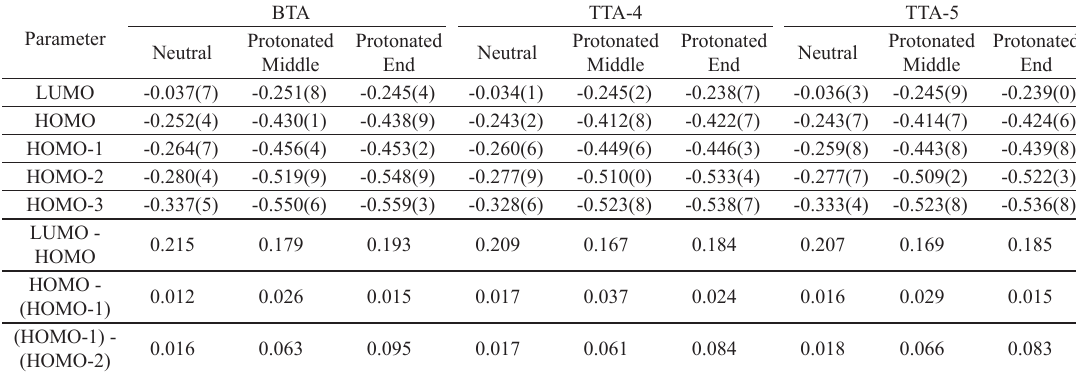
Figure 14. Protonation probabilities in the Structure of BTA and TTA. Table 6. Quantum physical and chemical parameters of BTA, TTA-4 and